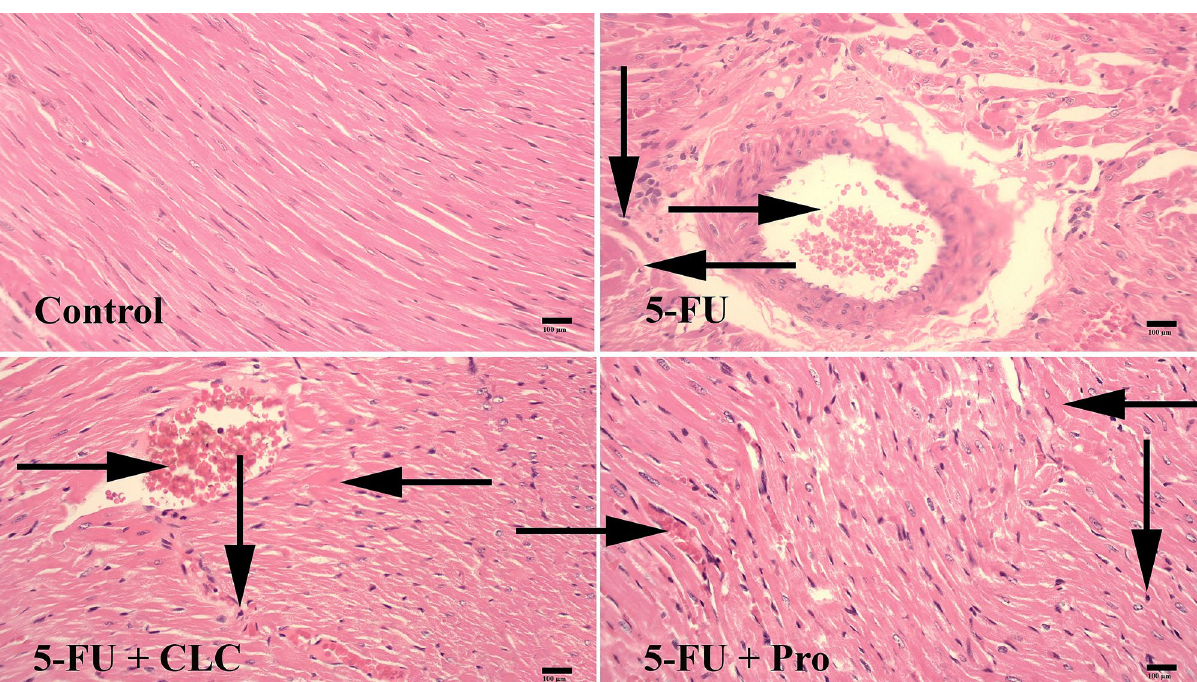
Figure 7. Effect of 5-fluorouracil and propolis administration on the histopathological changes of heart tissue samples. Groups: Control, Normal saline; 5-FU, 5-FU 125 mg/kg; 5-FU + Pro, 5-FU 125 mg/kg + Propolis ethanolic extract 250 mg/kg/d; 5-FU + CLC, 5-FU 125 mg/kg + Colchicine 5 mg/kg/d. Normal conditions in the Control group. Note hyperemia (rightward arrows), necrosis (downward arrows), and hyalinization (leftward arrows) in the 5-FU, 5-FU + Pro, and 5-FU + CLC groups. Hematoxylin and Eosin (H&E) staining. ×100